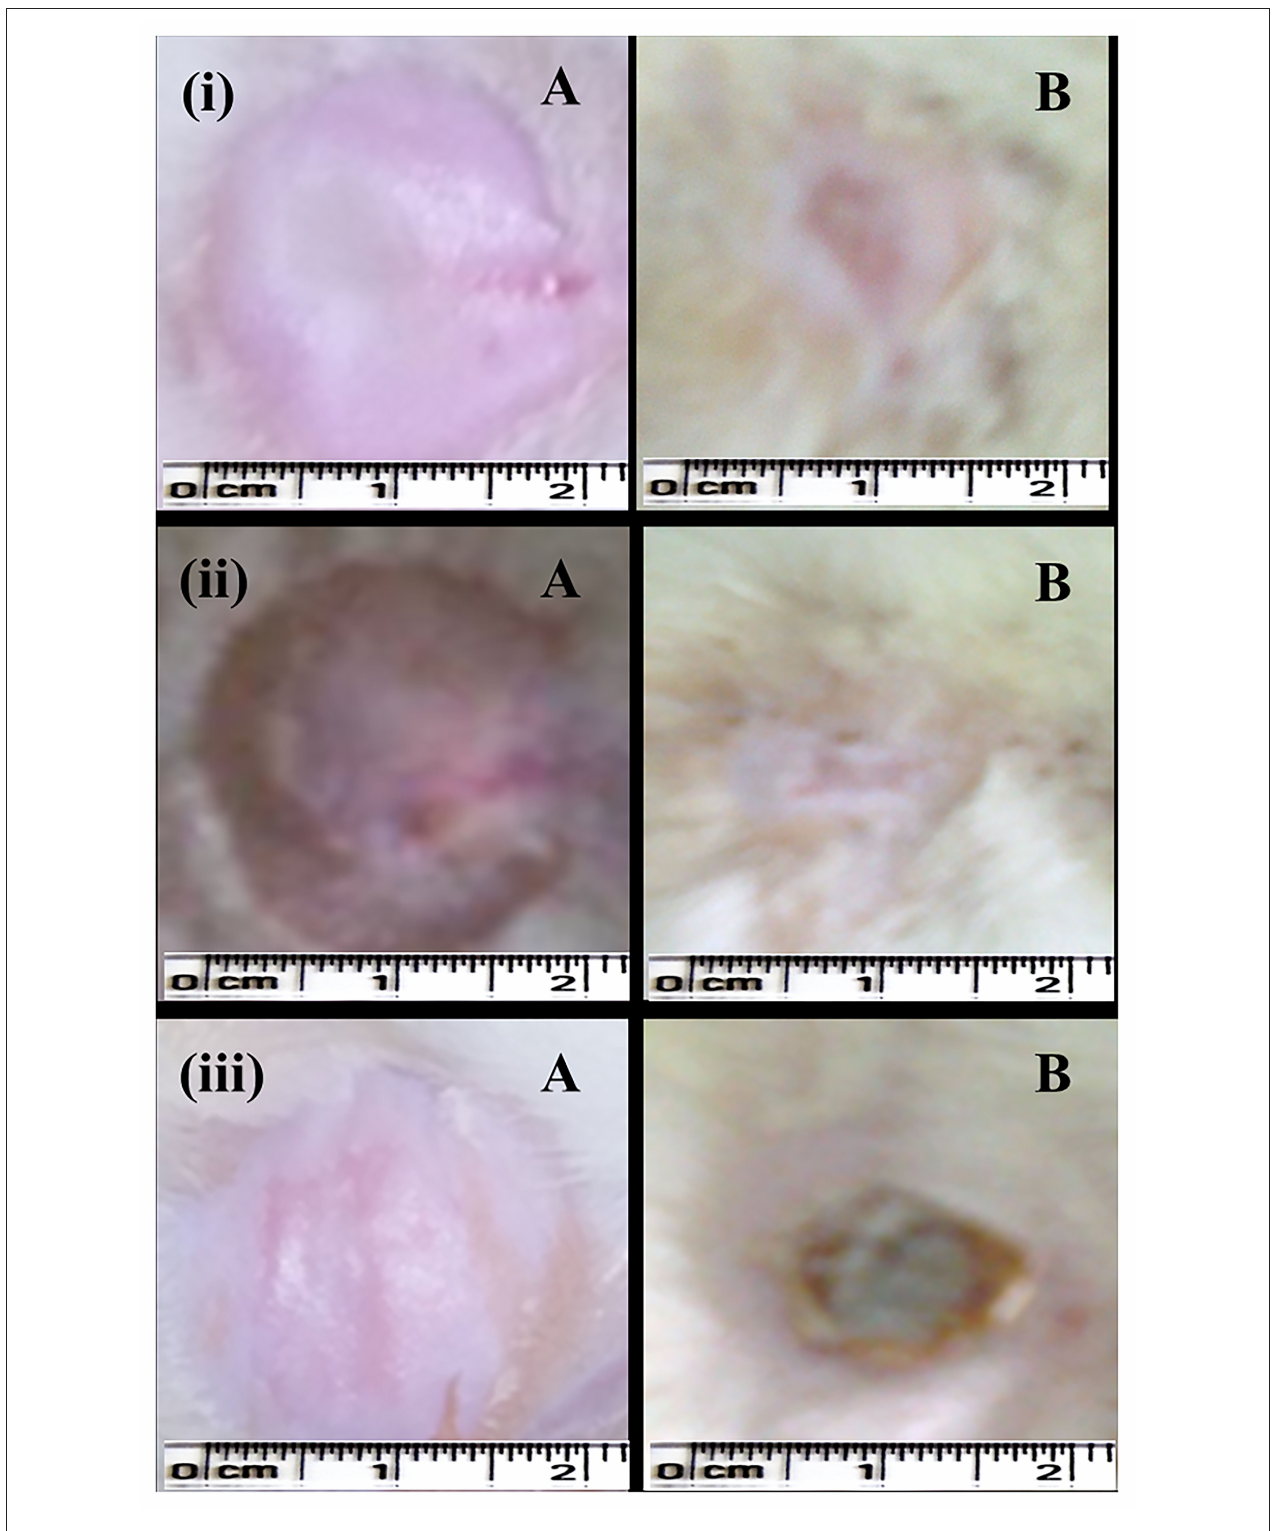
FIGURE 5 | Burn wound-healing model (albino Wistar) for formulated silver nanogel, marketed drug, and untreated (control) group. (i) Burn wound treated with silver nanogel at a concentration of 1mg g − 1 (Group C); (ii) Burn wound treated with marketed drug silverex 0.2% (Group D); (iii) Untreated (control) group (Group F), where (A) Burn wound created on the first day and (B) Burn wound healed on 15th day after treatment.